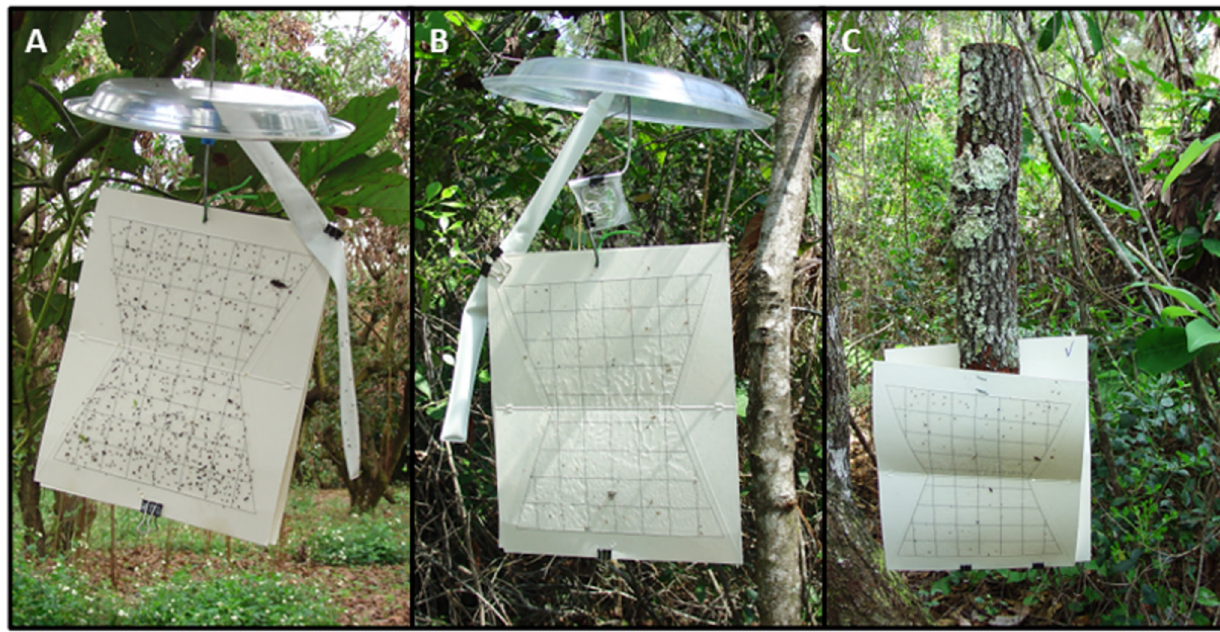
Figure 1. Sticky trap designs used to sample bark and ambrosia beetle communities at sites with laurel wilt. Representative photos depicting traps baited with ( A ) a low-release ethanol sleeve, ( B ) a combination of ethanol and essential oil lure, and ( C ) a bolt of host wood (silkbay, Persea humilis ). Traps in panel ( A ) were deployed in an avocado grove in Miami-Dade County, FL; traps in panels ( B , C ) were deployed in a swampbay forest in Highlands County, FL.